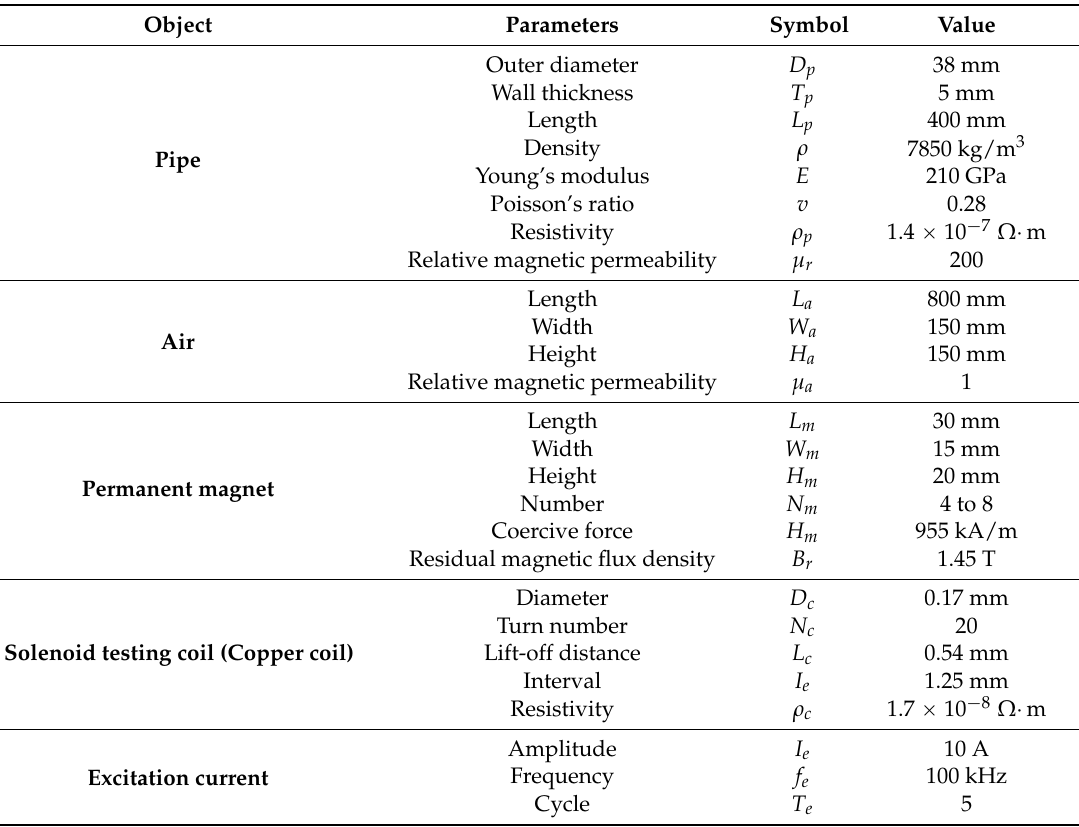
Table 1. Parameters of the simulation model used in this